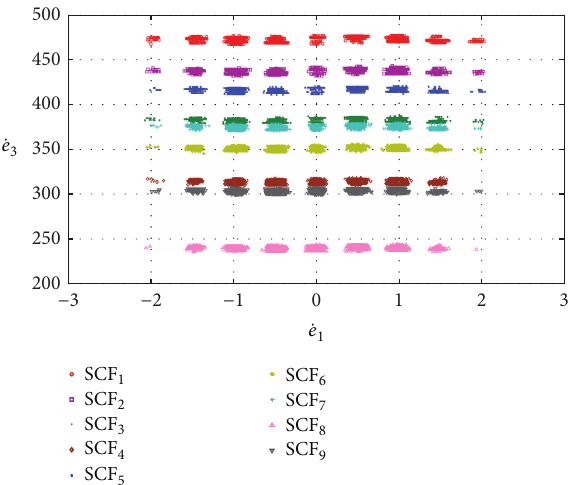
Figure 10: Plan view of ̇𝑒 1 – ̇𝑒 3 dynamic errors of SCF 1 –SCF 9 .